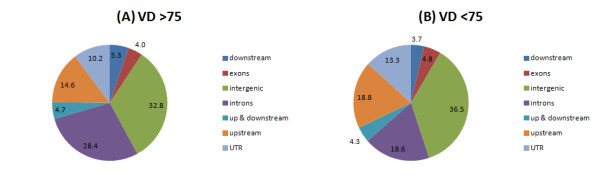
Genomic regions of VDR binding sites. The midpoints of each VDR ChIP-seq peak is shown for (A) samples with 25-hydroxyvitamin D ≥75 nM and (B) samples with 25-hydroxyvitamin D <75 nM. Up-, down- and up and downsteam are VDR binding sites within 5 kb of the nearest gene. Numbers show percentages of binding sites within each genomic region. ChIP-seq, chromatin immunoprecipitation and massively parallel sequencing; VDR, vitamin D receptor.